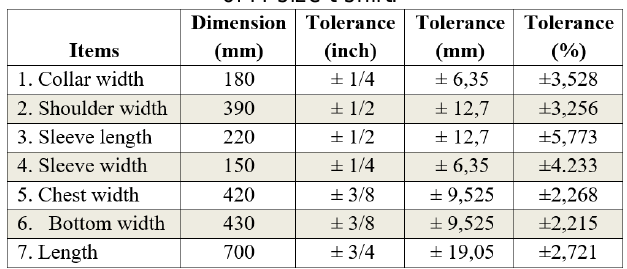
Table 1. Standard dimensions and allowable tolerance of M size t-shirt.